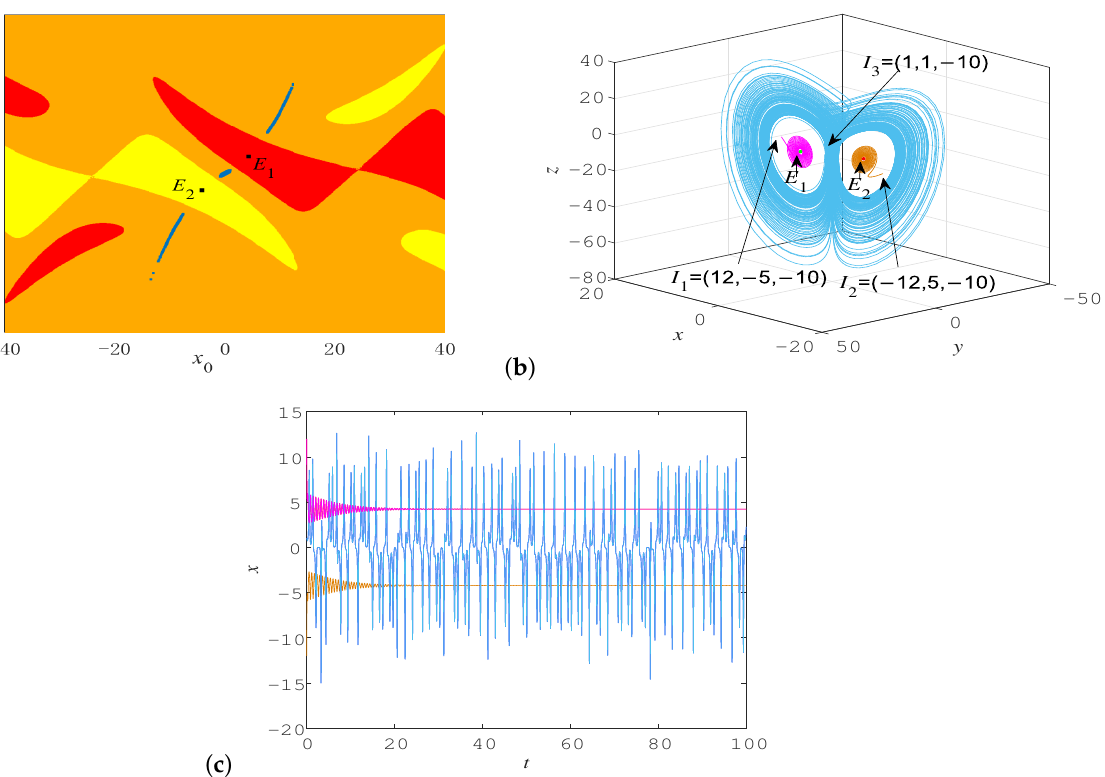
Figure 4. ( a ) Three colored basins of attraction at z = − 10 on ( x , y ) plane. ( b ) Three-dimensional (3D) views of the chaotic attractor and two fixed point attractors. ( c ) Coexisting time-series diagram of x ( t )